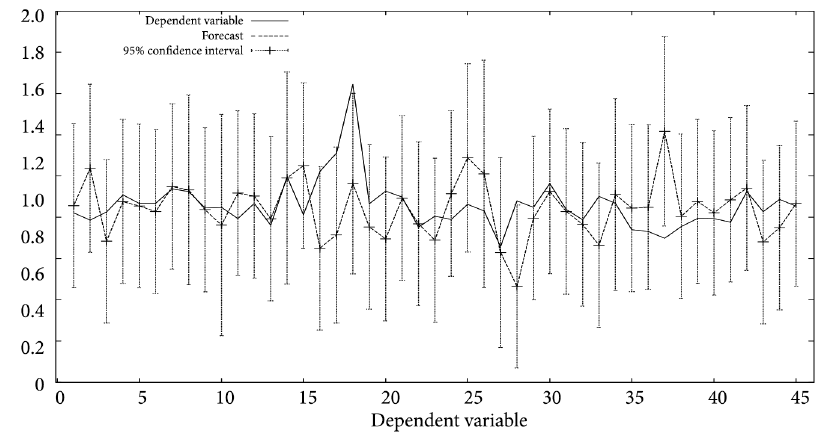
Figure 5. The forecast diagram on the evolution of the dependent variable for the 2 nd model (source: GRETL program)